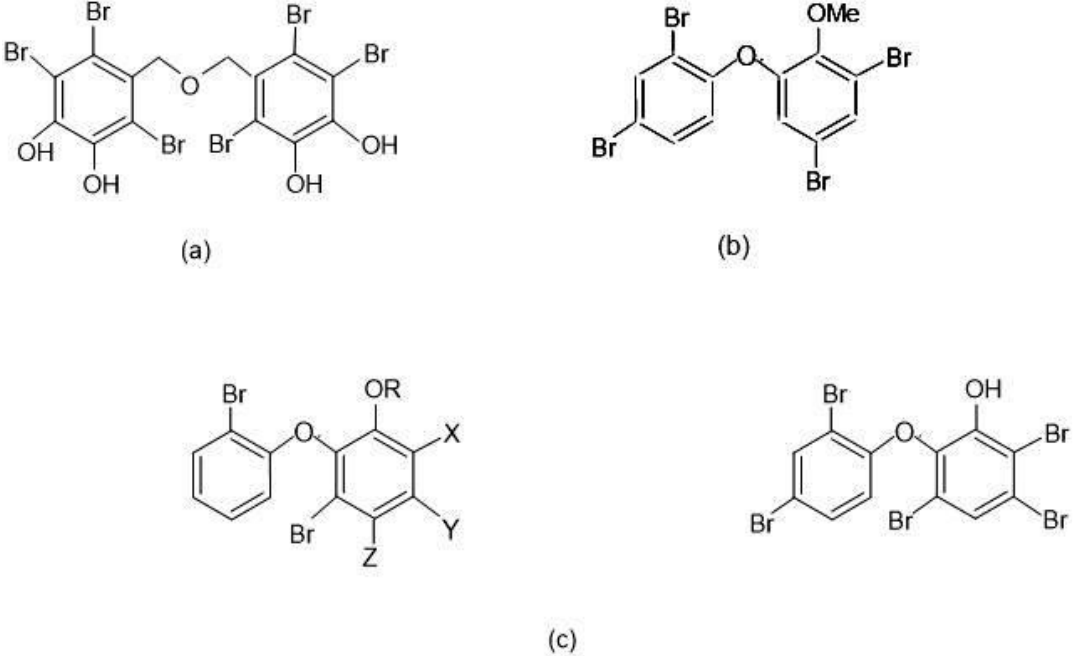
Figure 4. Polybrominated metabolites from marine ( a ) Red algae, ( b ) Green algae and ( c ) sponges, where ( i ) R=X=H; Y=Z=Br ( ii ) R=Z=H; X=Y=Br ( iii ) R=Y=H; X=Z=Br ( iv ) R=Me; Y=H; X-Z=Br [70,74– 77].